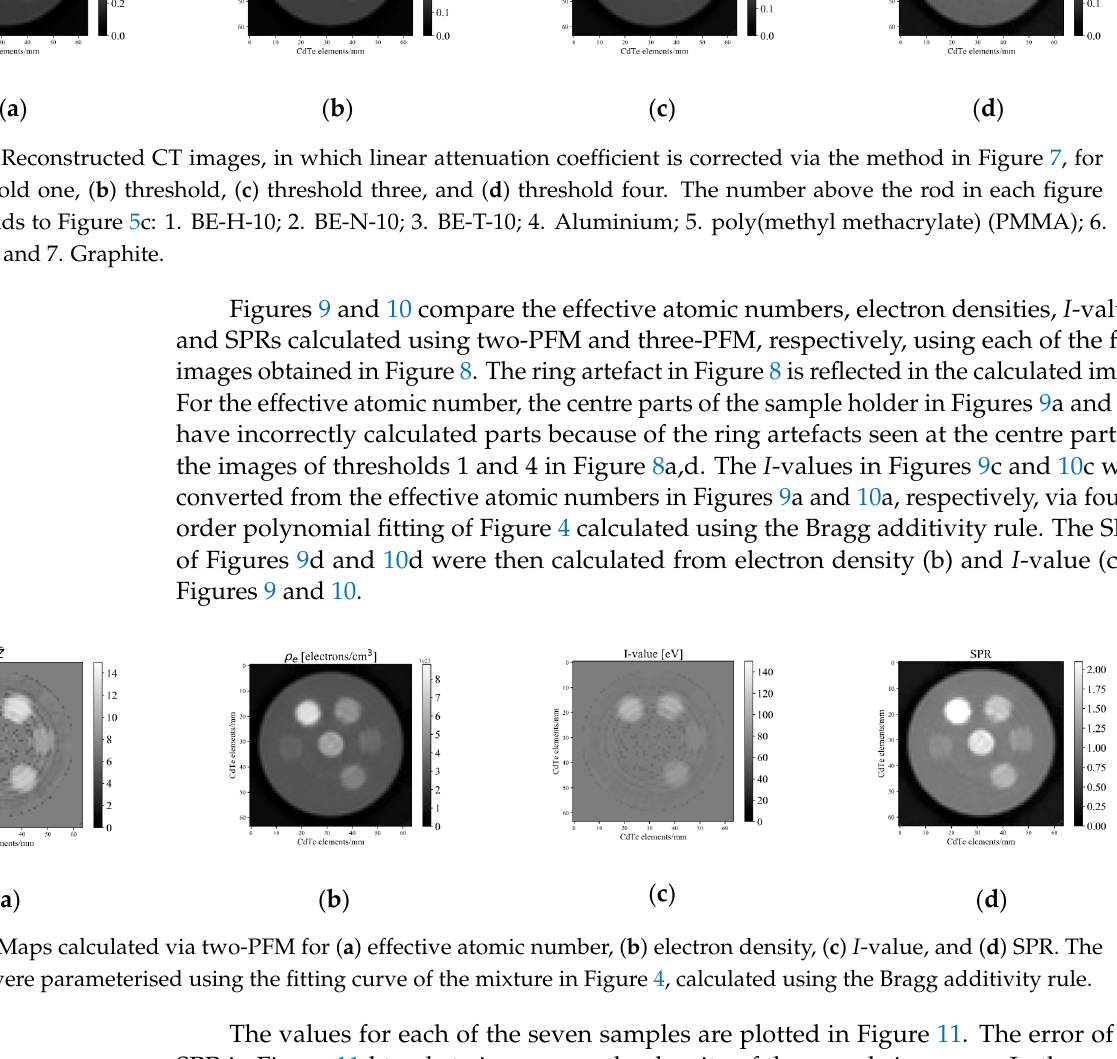
Figure 10. Maps calculated via three-PFM for ( a ) effective atomic number, ( b ) electron density, ( c ) I -value, and ( d ) SPR. The I -values were parameterised using the fitting curve of the mixture in Figure 4, calculated using the Bragg additivity rule. The values for each of the seven samples are plotted in Figure 11. The error of the SPR in Figure 11d tends to increase as the density of the sample increases. In the case of three-PFM, the overall relative error and standard deviation were less than those of two- PFM. Table 2 summarises the theoretical and experimental values and the relative errors for atomic number, electron density, I -value, and SPR. Figure 12 describes the theoretical values of the electron density and SPR in which 6% of noise level were added. As the electron density and SPR obtained from the experiment are within the error range of the theoretical value, it can be estimated that a noise level of about 6% may be included to the CT numbers obtained from the photon-counting CT. For three-PFM, the overall standard deviation was less than those of two-PFM.